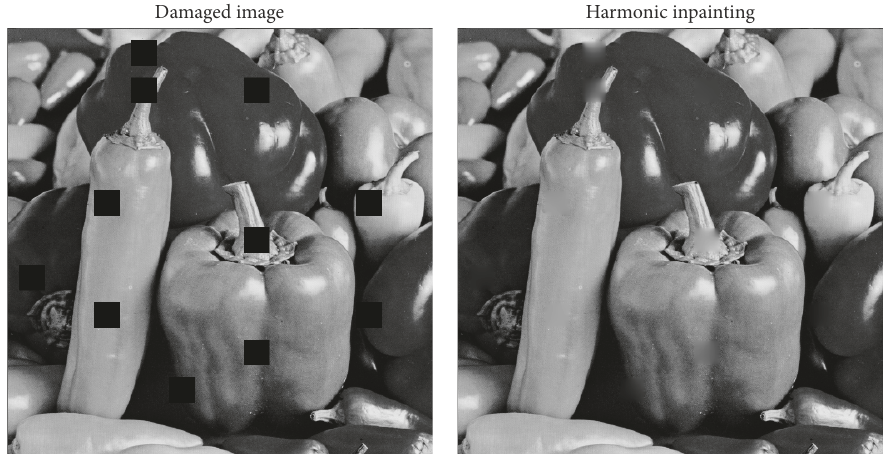
Figure 7: Damaged image and restored image by harmonic functions.